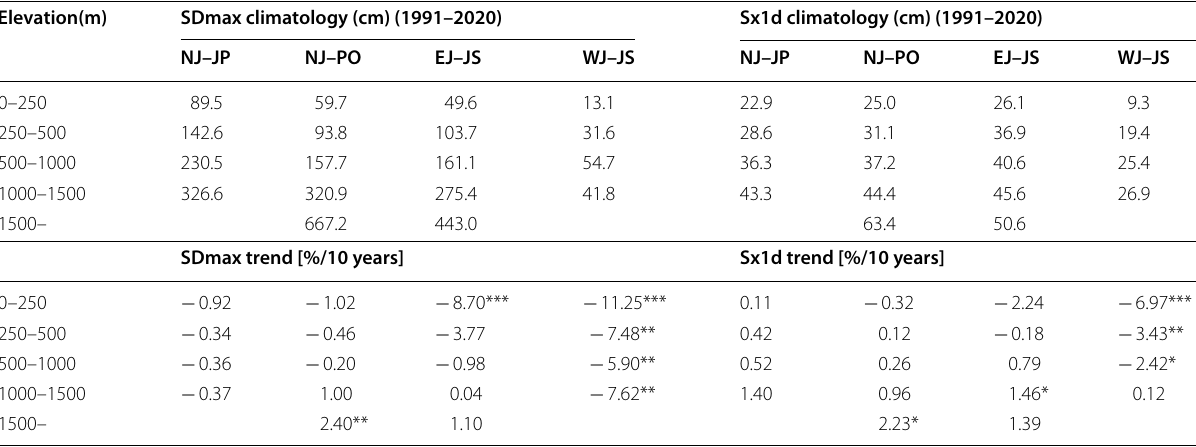
One, two, and three asterisks mean a statistical significance with 90%, 95%, and 99% confidence levels, respectively